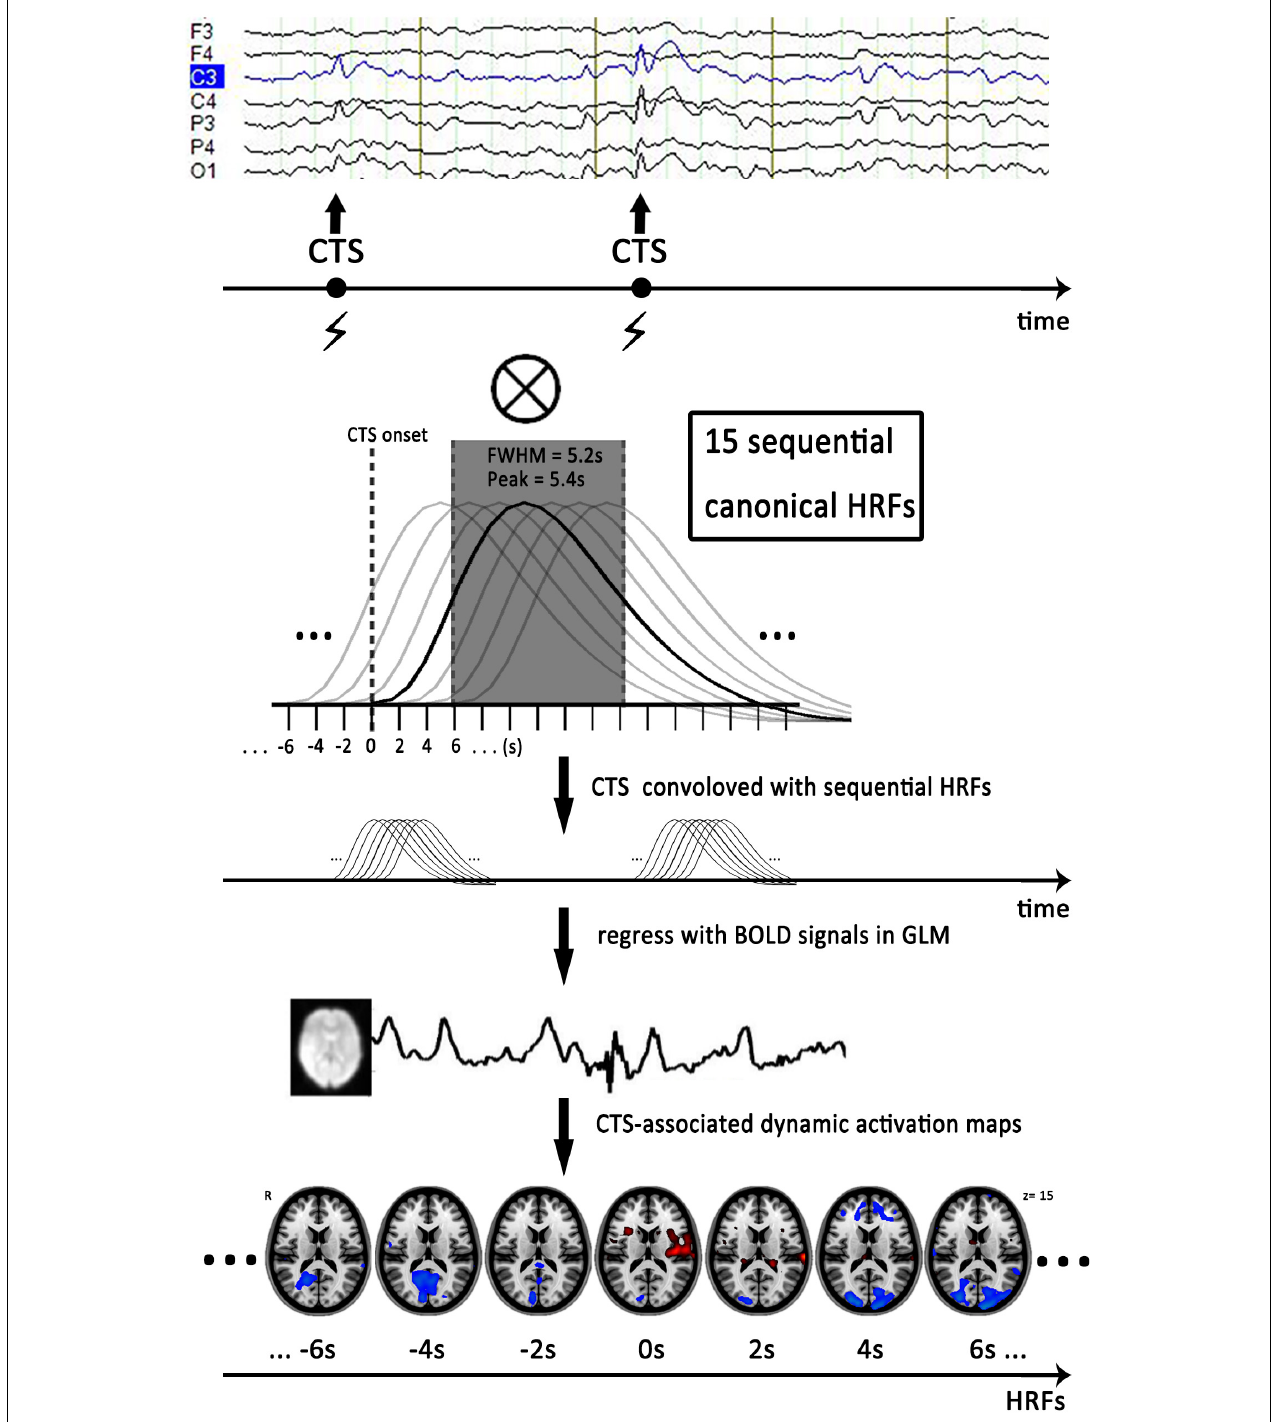
FIGURE 1 | Flow chart of dynamic EEG-fMRI analysis. First, we marked time of centrotemporal spikes (CTS) onset on EEG by electroencephalographers. Second, we generated sequential HRFs consisting of 15 successive gamma functions of full-width half-maximum of 5.2 s, peak = 5.4 s and spaced 2 s between one another to model the dynamic BOLD changes induced by CTS. Finally, we convolved a boxcar function expressing the timing of CTS with sequential HRFs shifted from 14 s before to 14 s after the CTS (time point -14 to 14 s), to generate a series of regressors that modeled the dynamic activation/deactivation in individual level. Horizontal axis represented start time of the sequential HRFs. Actually, analysis with HRF centered at zero point (time point 0 s) was the conventional EEG-fMRI result with single HRF. The EEG and activation maps are from one of the patients with drug-naive. CTS, centrotemporal spikes; EEG, electroencephalography; HRF, hemodynamic response function; FWHM, full-width half-maximum; GLM, general-liner-model.